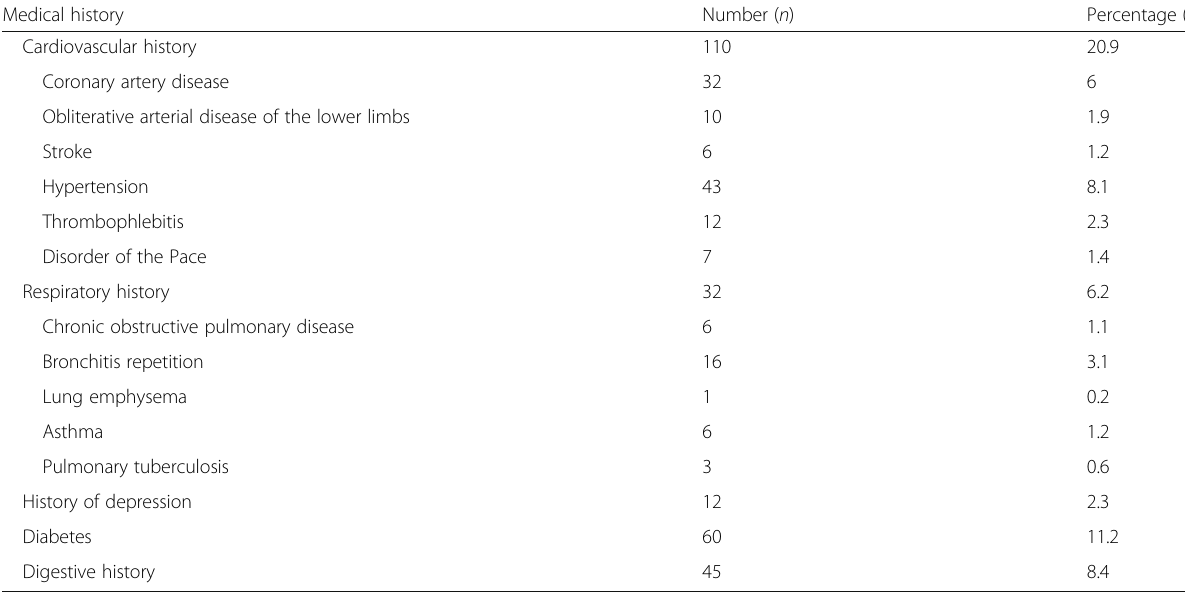
Table 2 Description of medical characteristics of smokers attending the smoking cessation clinic of the University Hospital Sahloul, Sousse, 2009 – 2015